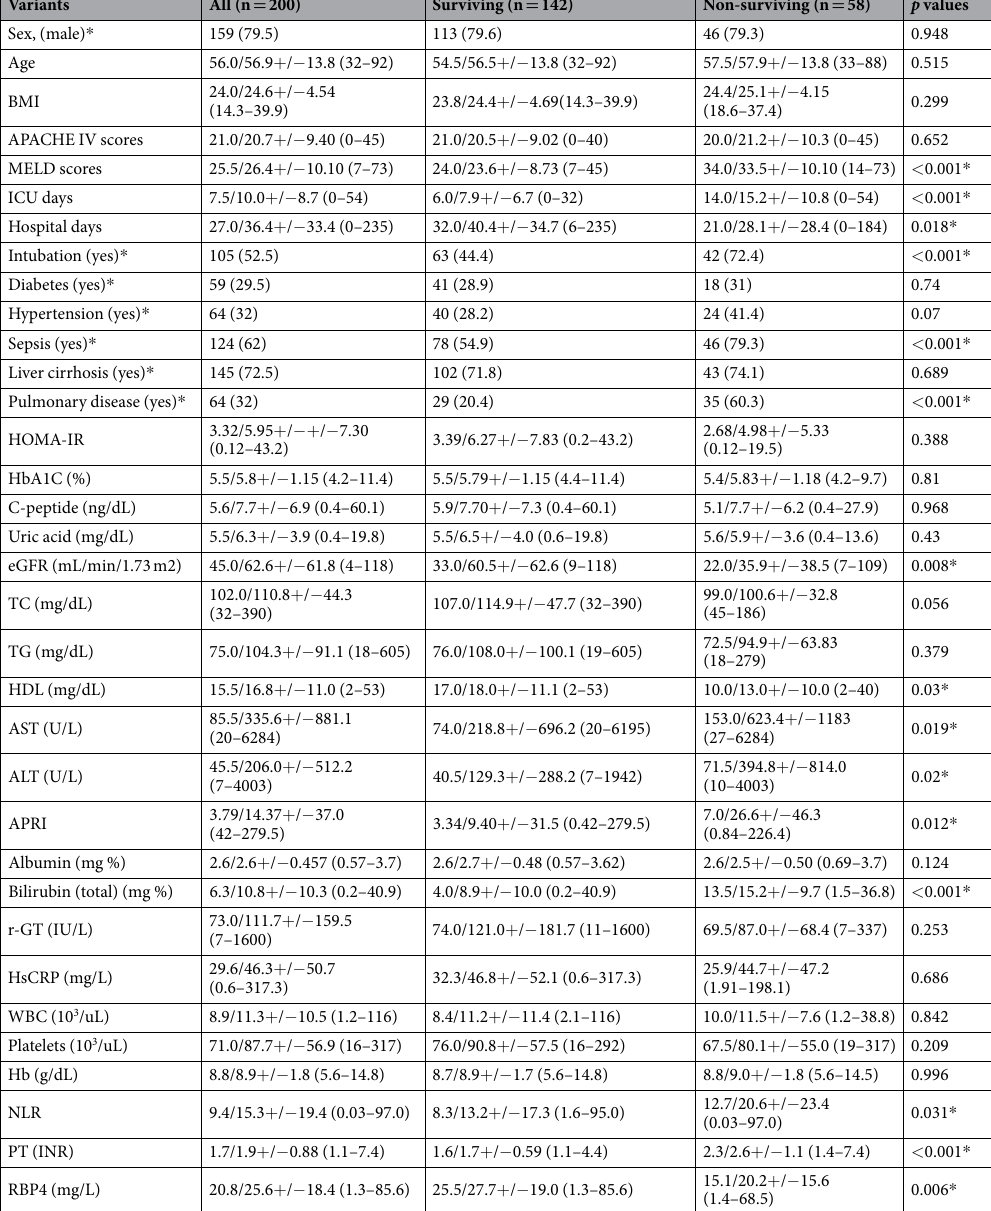
Table 1. Baseline characteristics of the ICU patients [median/mean + / − standard deviation (range)]. * n (%); BMI: body mass index; MELD: model for end-stage liver disease; APACHE: acute physiology and chronic health evaluation; ICU: intensive care unit; HOMA-IR: homeostatic model assessment for insulin resistance; HbA1c: hemoglobin A1c; TC: total cholesterol; TG: triglyceride; HDL-C: high-density lipoprotein cholesterol; AST: aspartate aminotransferase; ALT: alanine aminotransferase; APRI: aspartate aminotransferase-to-platelet ratio index; r-GT: r-glutamyltransferase; HsCRP: high-sensitivity C-reactive protein; WBC: white blood cell count; NLR: neutrophil-to-lymphocyte ratio; PT: prothrombin time; INR: international normalized ratio; RBP4: retinol-binding